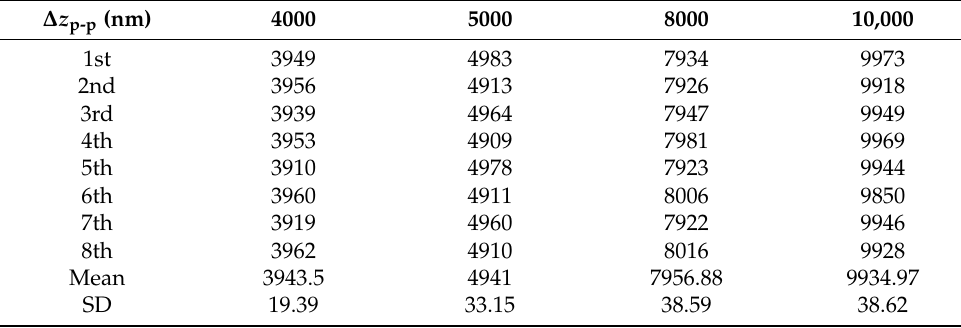
Table 2. Measurement results of out-of-plane displacement ∆ z